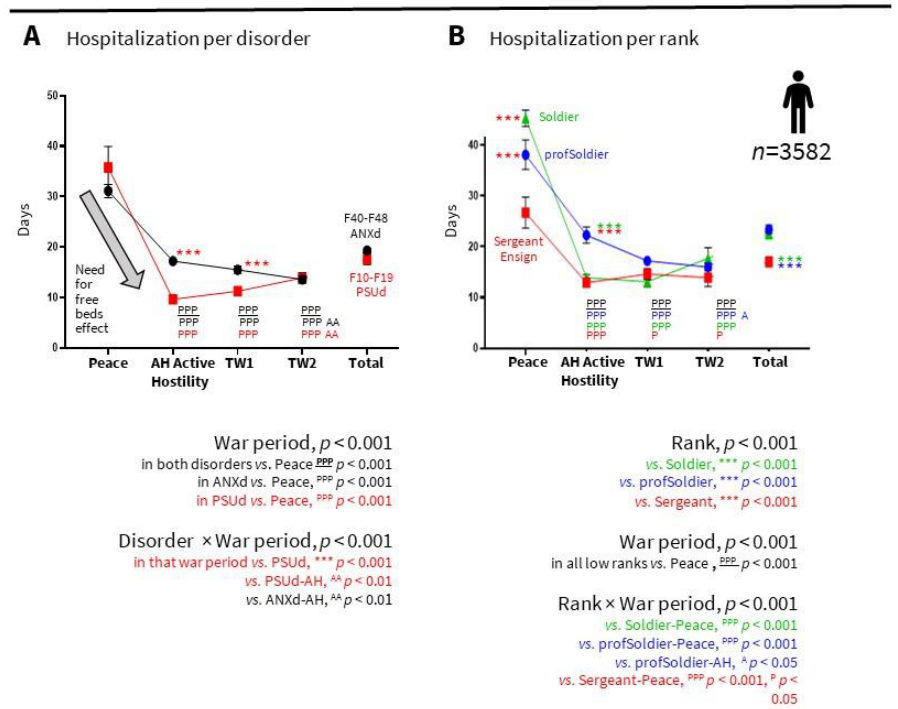
Figure 4. Days of hospitalization. ( A ) Days of hospitalization per disorder, and ( B ) per military rank. ANXd: Anxiety, dissociative, stress-related, somatoform and other nonpsychotic mental disorders; PSUd; Mental and behavioral disorders due to psychoactive substance use. Statistics (see depicted in the insets): Frequencies (%), Chi-square; and Mean ± SEM, ANOVA with post hoc Bonferroni.